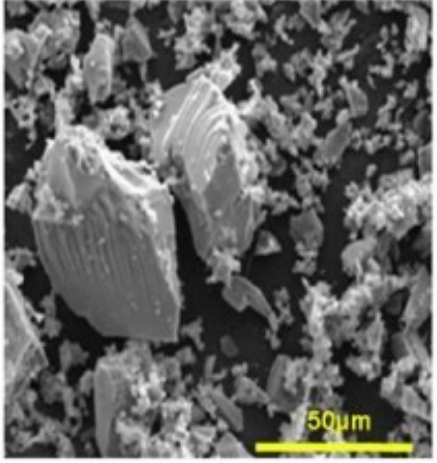
Figure 1. Surface of a mesoporous bioactive glass [11]. Scale bar: 50 µ